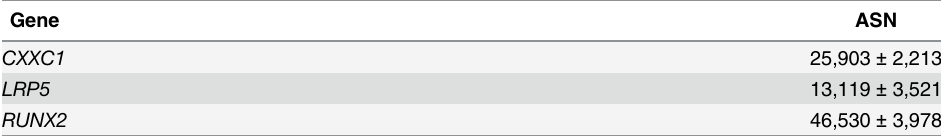
Table 2. Age estimations (in years ± SD) of the selected haplotypes with star like genealogy in East Asians